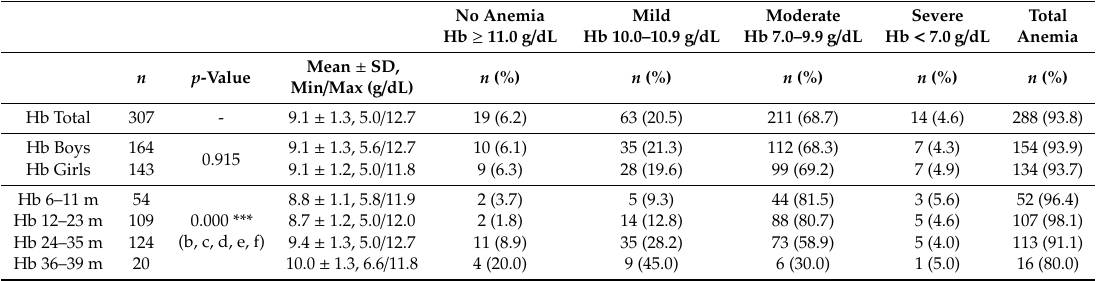
Table 3. Hemoglobin levels among surveyed Santal children (total), as well as by gender and by